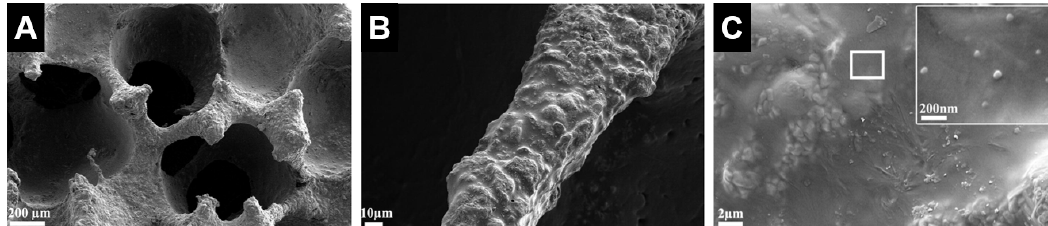
Figure 9. Scanning electron microscope images of baghdadite scaffolds reinforced with a PCL coating containing bioactive glass nanoparticles showed that ( A ) the scaffolds maintained a highly porous structure after coating; ( B ) the coated struts had a smooth surface with absence of visible cracks or pores; and ( C ) the coating was homogeneous with evenly dispersed bioactive glass nanoparticles within the PCL [71]. Adapted by permission of Elsevier, Copyright © 2012.